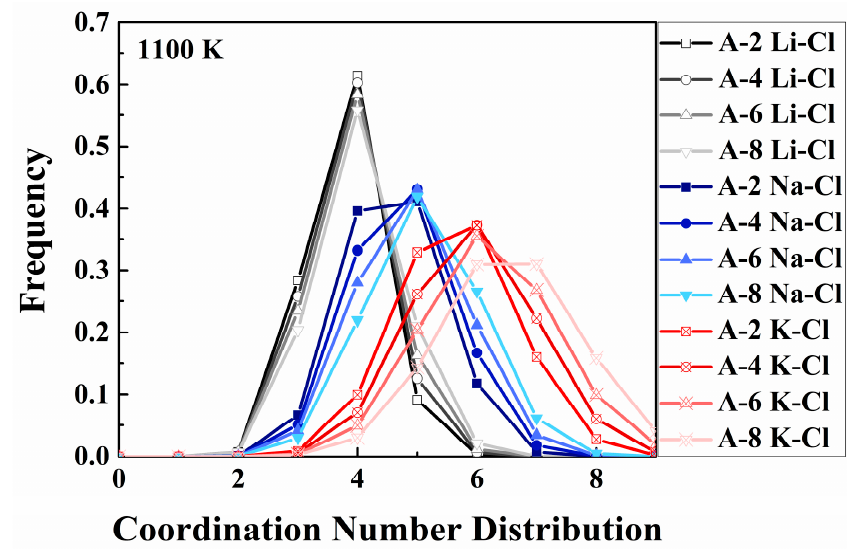
Figure 3. The coordination numbers distribution of four compositions at 1100 K for Li-Cl, Na-Cl, K-Cl, respectively.